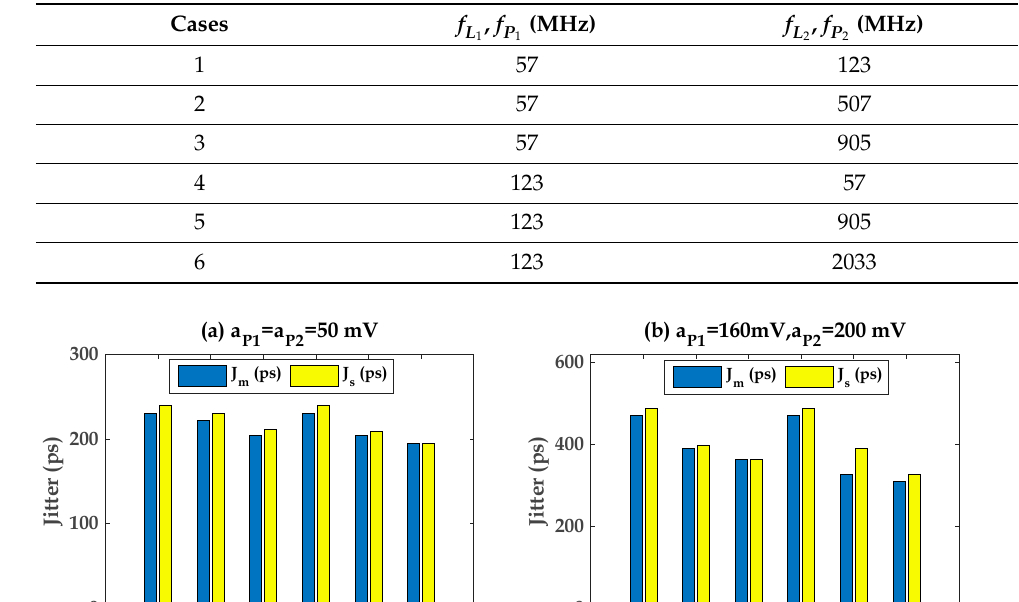
Table 8. Last stage and pre-driver: frequency settings of Figures 14 and 15.